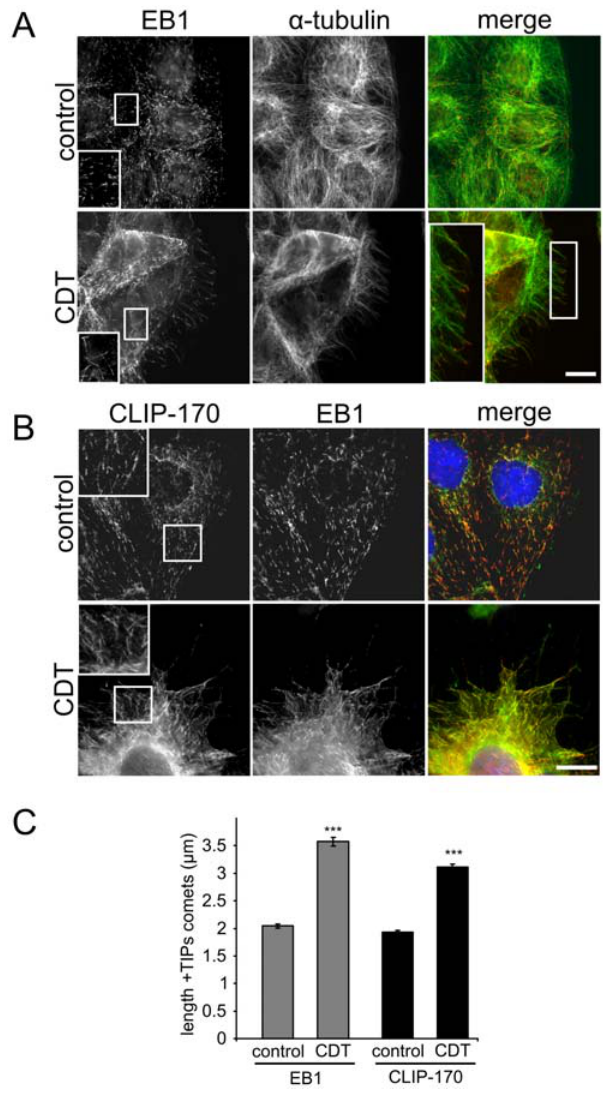
Figure 3. Influence of CDT on EB1 and CLIP-170 at microtubule plus-ends. ( A ) Indirect immunofluorescence of EB1 (red) and a -tubulin (green) in Caco-2 cells. Control cells show short comet-like EB1 associations at the tip of microtubules. After CDT treatment, EB1 comets are elongated and also present at the tip of microtubule-based protrusions. Cells were treated with 20 ng/ml CDTa and 40 ng/ml CDTb and fixed after 2 h. Areas in white squares show magnifications. Scale bar represents 20 m m. ( B ) Indirect immunofluorescence of CLIP-170 (green) and EB1 (red) in Caco-2 cells. The nucleus was stained by DAPI (blue). EB1 and CLIP-170 comets are elongated after CDT treatment. Cells were treated with 20 ng/ml CDTa and 40 ng/ml CDTb and fixed after 2 h. Areas in white squares show magnifications. Scale bar represents 20 m m. ( C ) Quantification of the EB1 and CLIP-170 comet lengths. The figure shows a quantification of the EB1 and CLIP-170 comet length from pictures stained as in Figure 3B. After CDT treatment, both + TIPs have an increased microtubule tip association. + TIPs were measured by Metamorph software. Data are given + / 2 SEM (***=p , 0.001, n=100). CDT concentrations were as